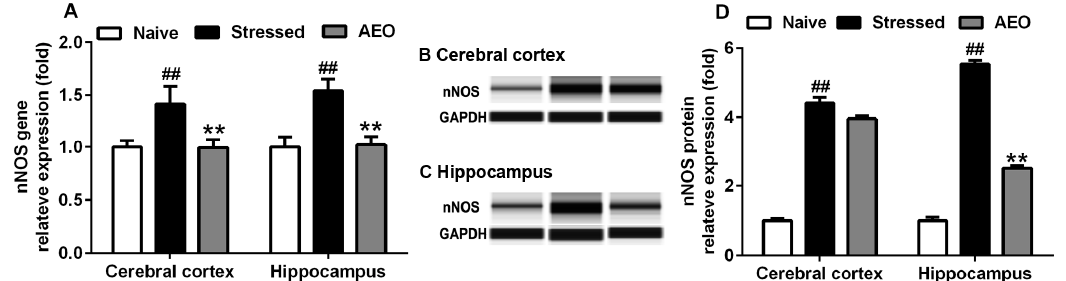
Figure 7. Effects of AEO on ( A ) neuronal nitric oxide synthase (nNOS) gene transcription and ( B ) protein expression in the cerebral cortex and ( C ) hippocampus of mice. ( D ) The quantitative results of relative protein expression are shown in fold. Each value represents mean ± SEM, n = 3 with three independent biological replicates, ## p < 0.01 vs. the naive group, ** p < 0.01 vs. the stressed group.